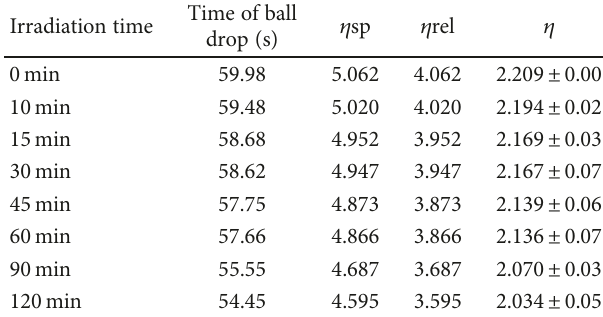
Table 1: Values of time of ball drop (seconds), speci fi c viscosity ( η sp ), relative viscosity ( η rel ), and intrinsic viscosity ( η ) calculated for a GAP solution at di ff erent irradiation